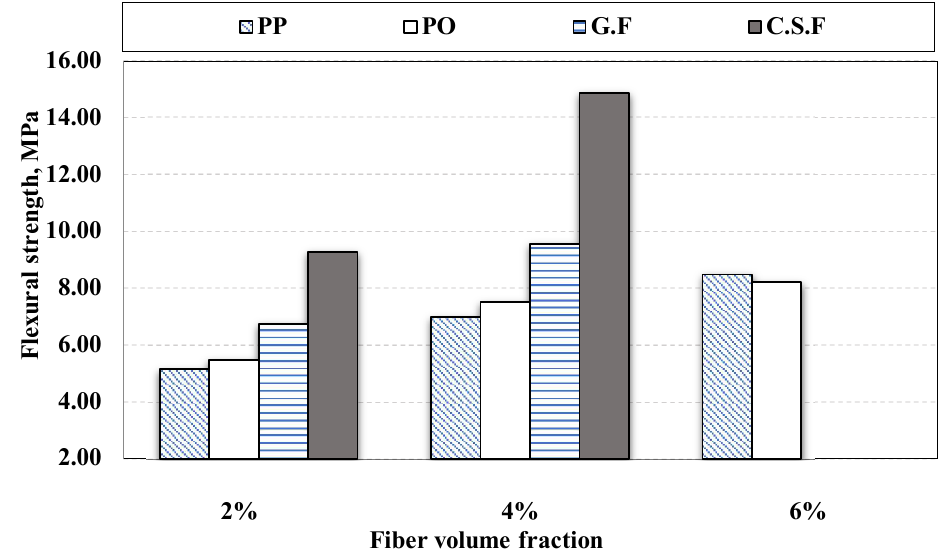
Figure 12. Flexural strength at 28 days due to fiber type change.